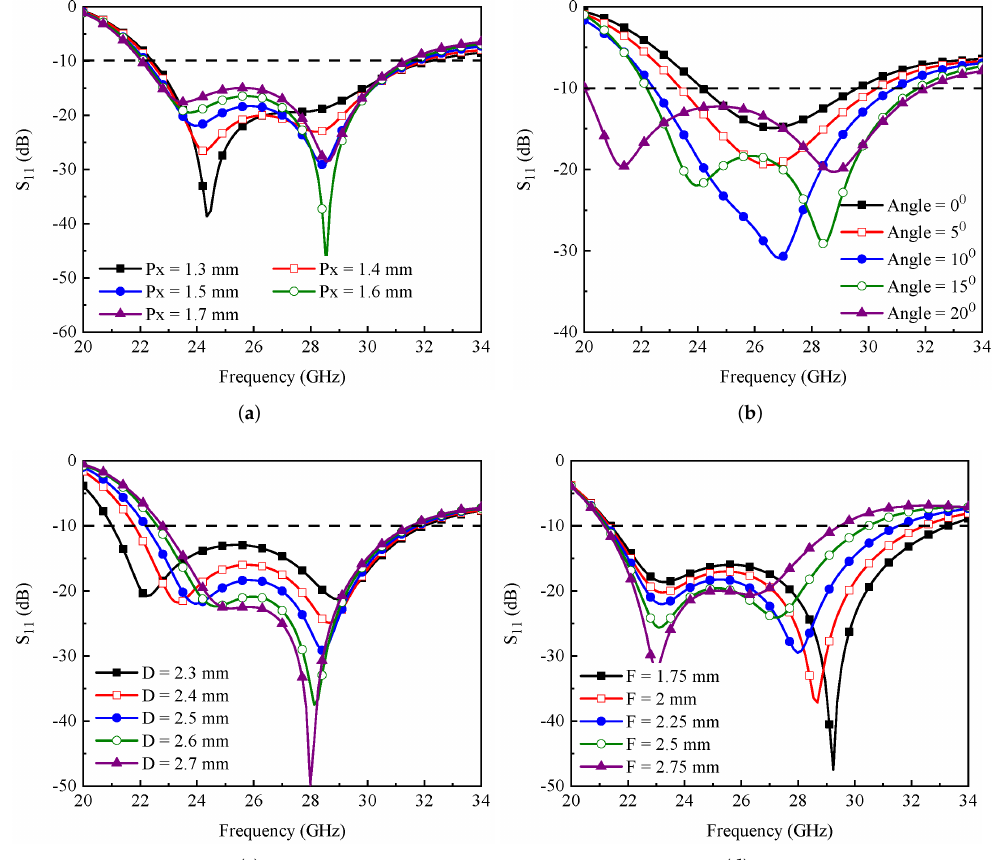
Figure 3. Effect of ( a ) square notch width “Px”, ( b ) strip angle, ( c ) plow-shaped horizontal strip “D”, and ( d ) T-shaped resonator length “F” on antenna’s